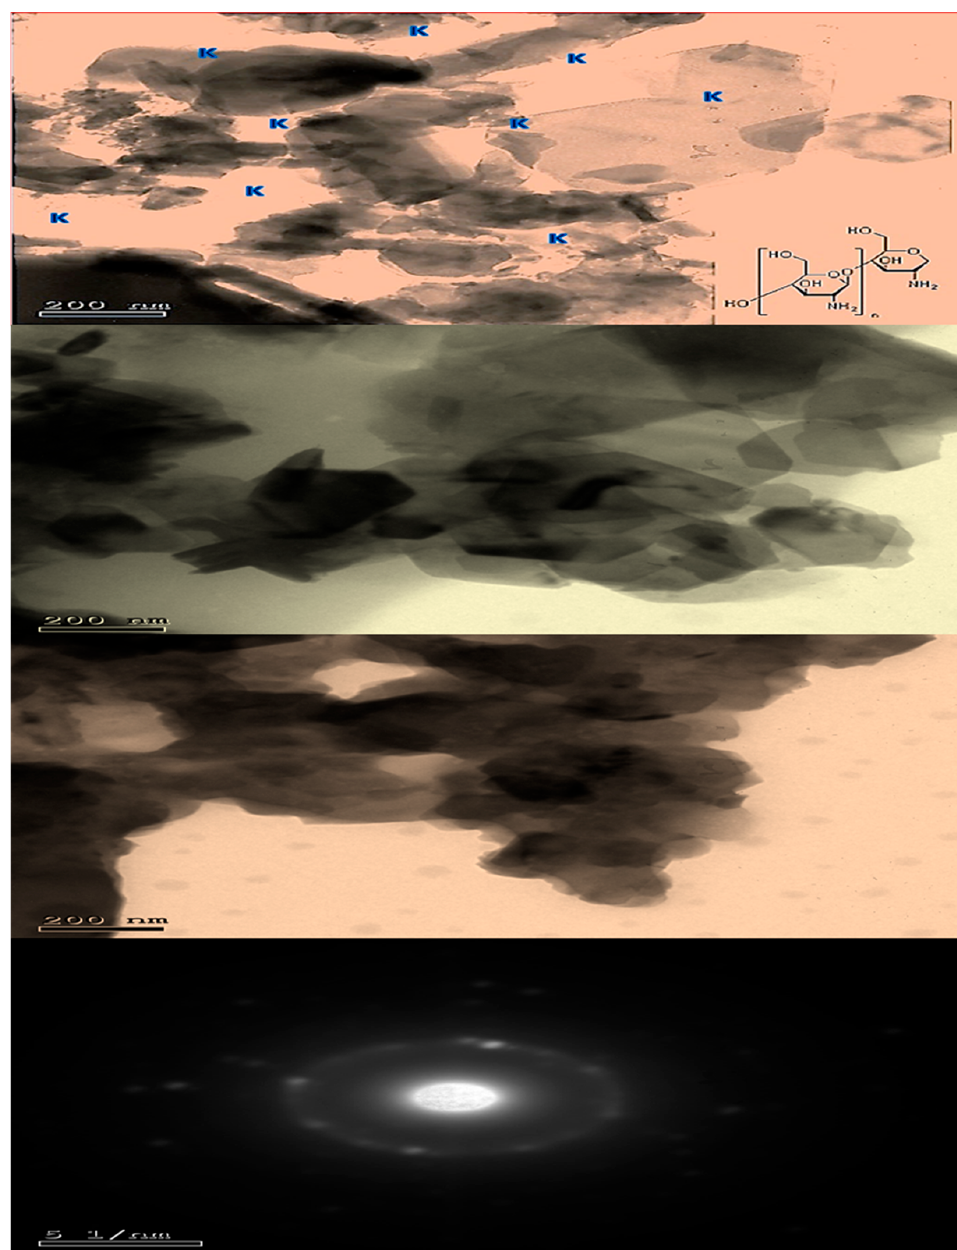
Figure 1. Transmission electron microscopy (TEM) images of nano-chitosan loaded with K with size ≤ 200 nanometers (nm).